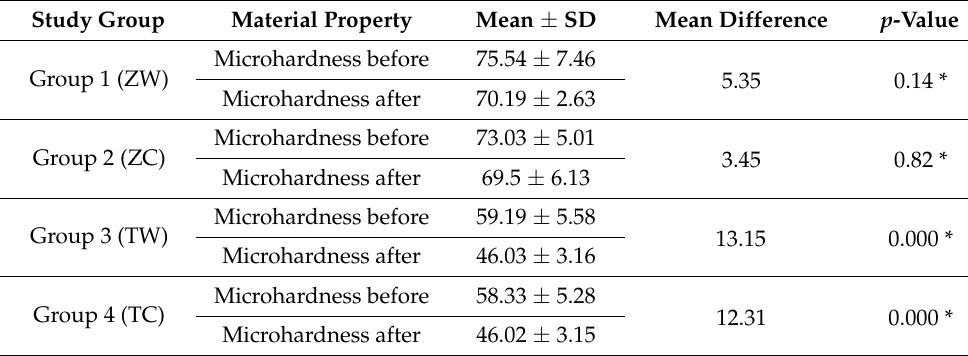
Table 2. Comparison of Microhardness (VHN) means among study groups. Study